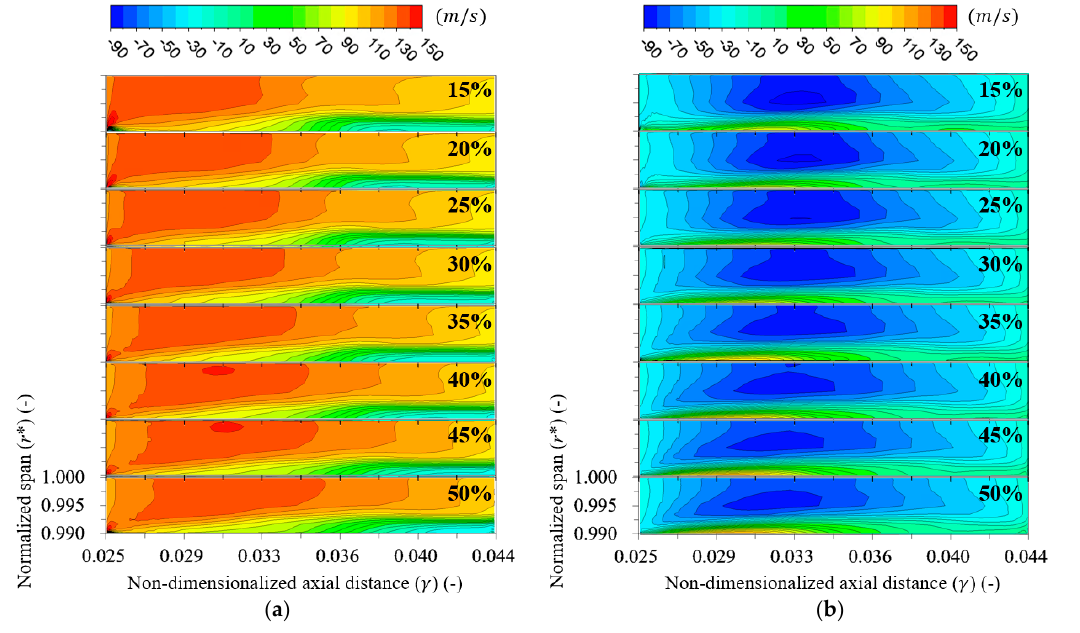
Figure 17. Contour of ( a ) the circumferential velocity component ( V θ ) and ( b ) the axial velocity component ( V z ) on the meridional plane of the tip clearance with di ff erent maximum thickness positions ( Φ / Φ des = 1.0).